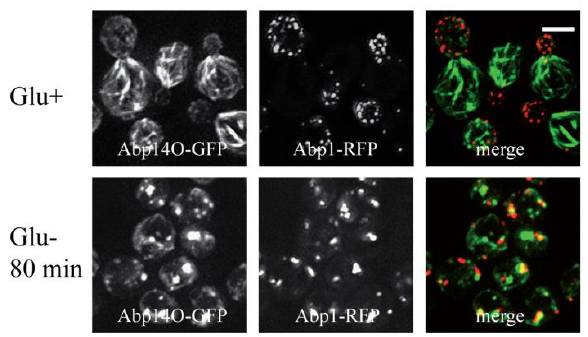
FIGURE 5: S. cerevisiae (rho 0 ) cells co-expressing Abp1-RFP and Abp140-GFP from chromosomal sites (strain CRY1454). Exponen- tially growing cells were inspected directly in the presence of glucose (Glu+) or after 80 minutes glucose-deprivation in the me- dium without glucose (Glu-). Distribution of fluorescent markers is presented after deconvolution and projection of several images in the stack (Z-stack) using Xcellence software (Olympus). Bar, 5 µm.